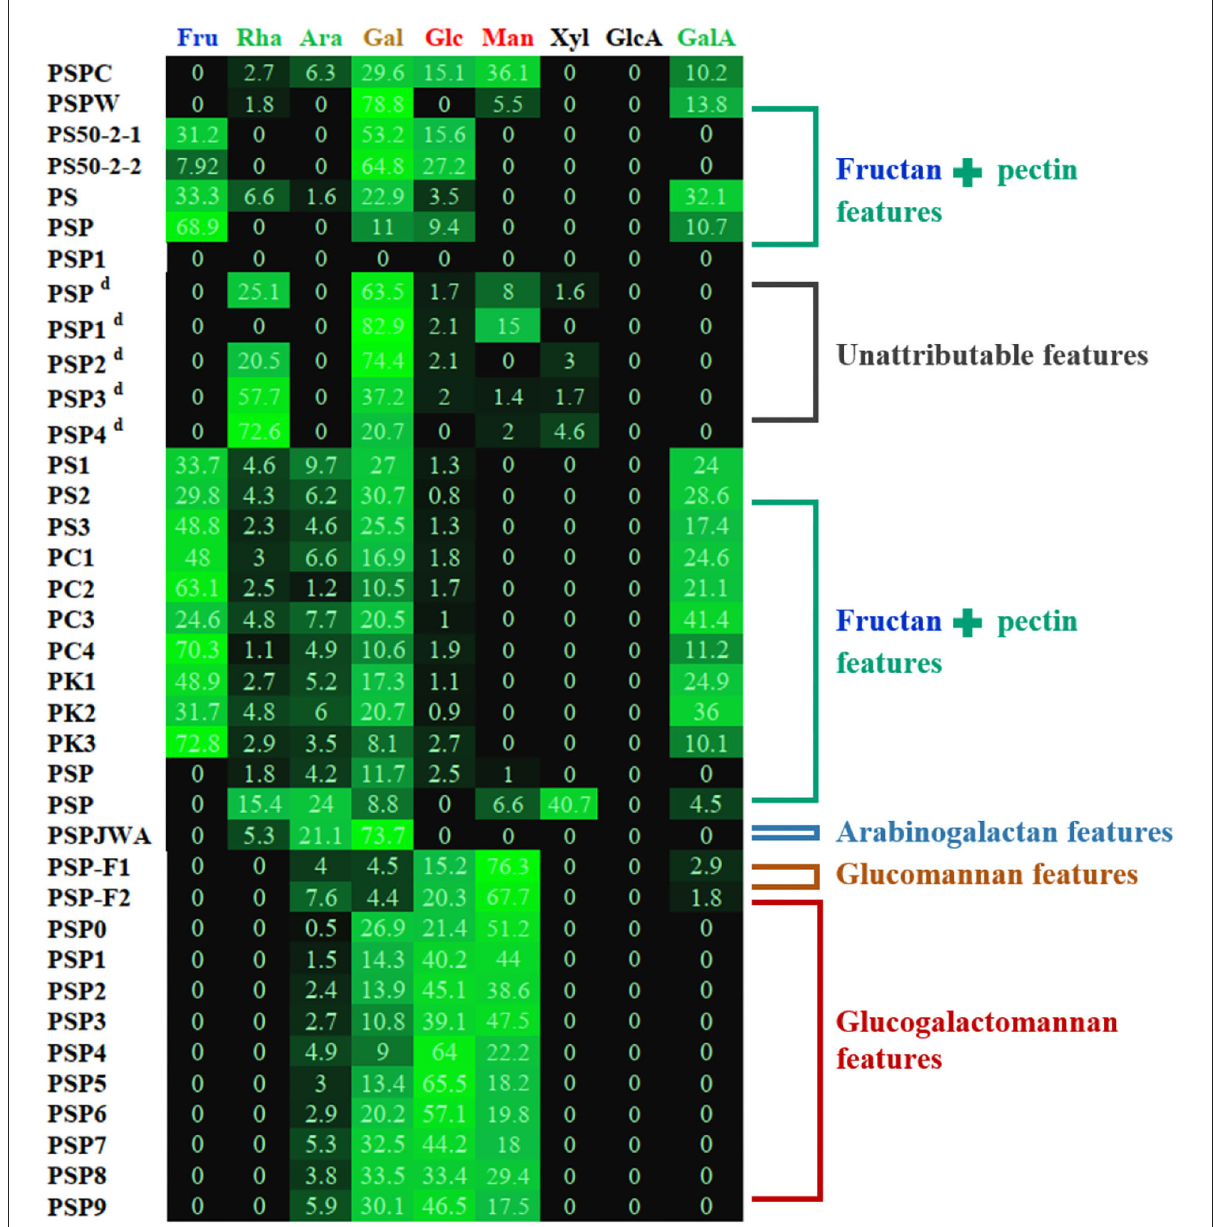
FIGURE3 Heat map of monosaccharide of PSP based on summarized data (as shown in Table 1). d : The determination of uronic acids (GalA and GlcA) was not mentioned in original papers, and the monosaccharide composition data were possibly calculated except for the uronic acids. Other details can be found in Table